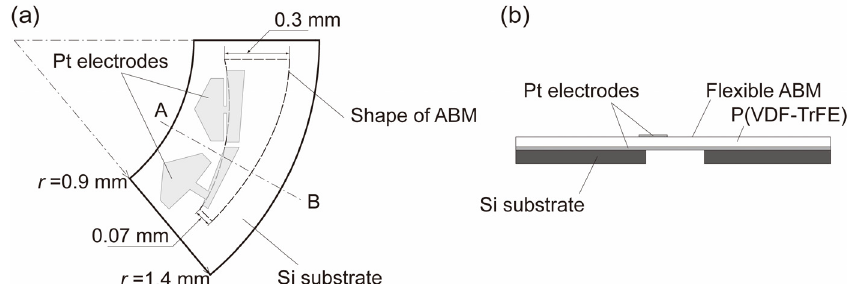
Fig. 1 Schematic of fully self-contained implantable artificial cochlea (7) ; (a) top view and (b) cross sectional view at AB of